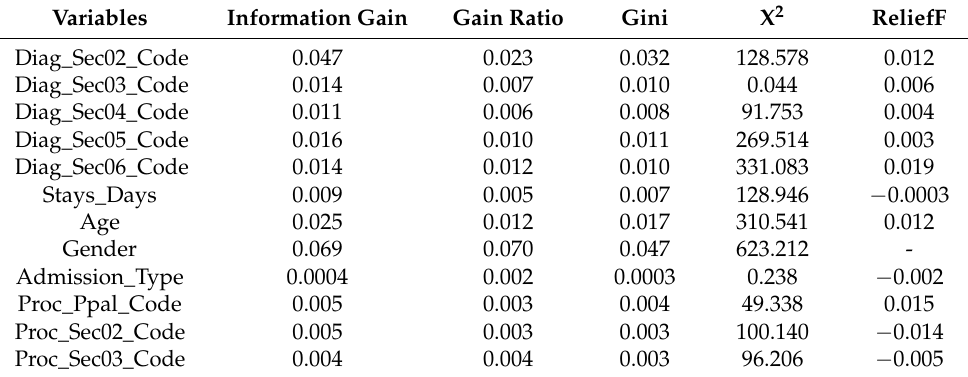
Table 1. Metrics and ranking of the features.